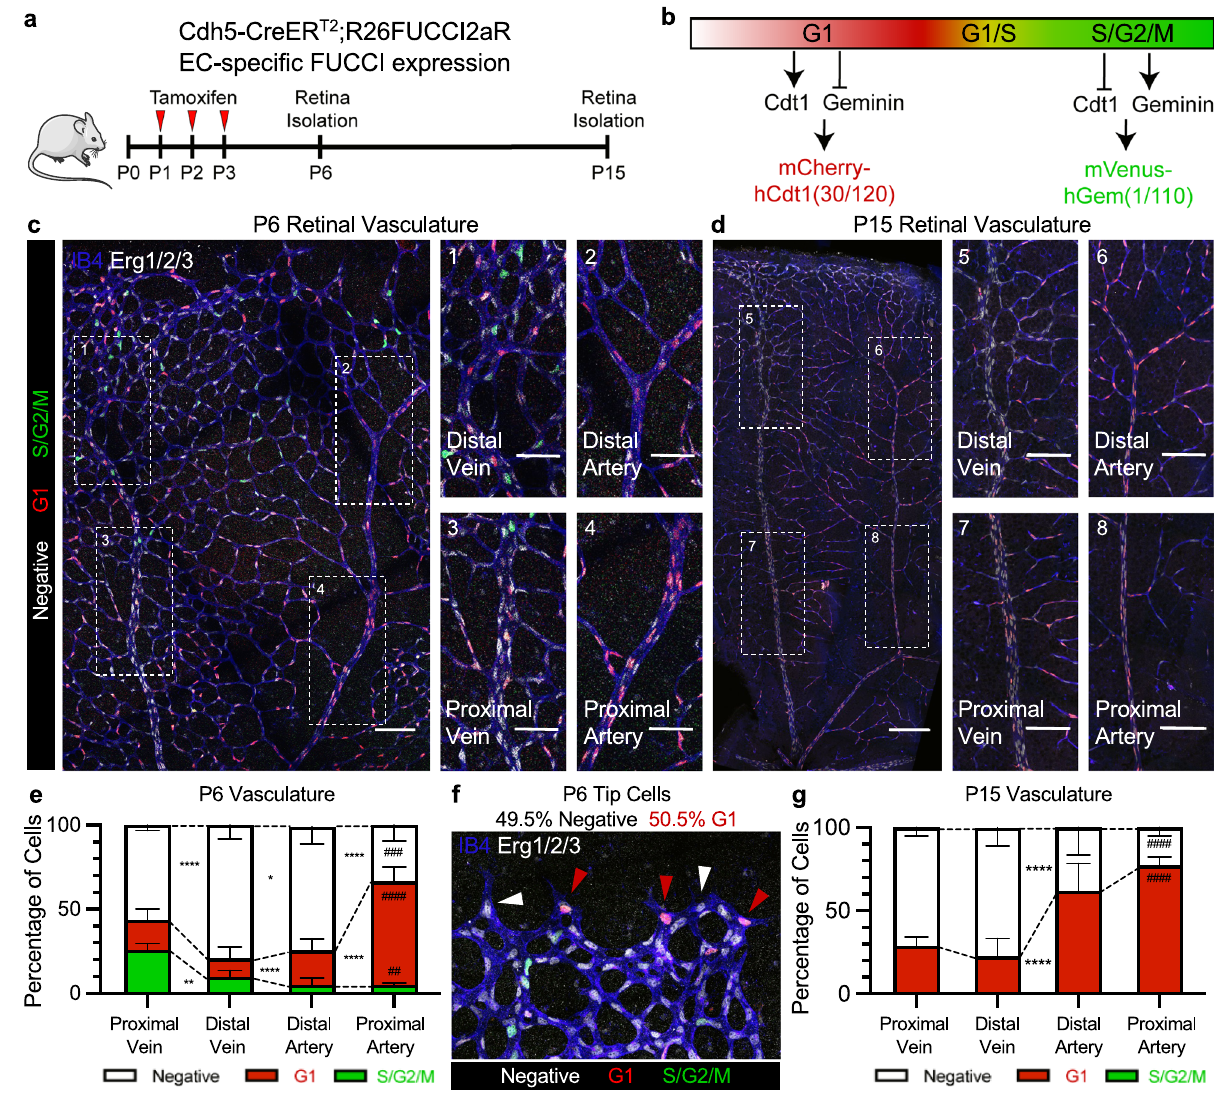
Fig. 1 | Endothelial cell cycle state during retinal vascular development. a , b Cdh5-CreER T2 ;R26FUCCI2aR transgenic mouse allows for tamoxifen-induced endothelial cell-speci fi c expression of the FUCCI reporter, which uses dynamic degradation of mVenus-hGem(1/110) and mCherry-hCdt1(30/120) in different cell cycle states to distinguish FUCCI-Negative, FUCCI-Red G1, and FUCCI-Green S/G2/M cell cycle states. c Representative confocal image of P6 retinas from Cdh5- CreER T2 ;R26FUCCI2aR mice immunostained with IB4 and anti-Erg1/2/3 (scale bar= 150 μ m), 1 – 4) magni fi ed images of vein and artery branch sections (scale bar= 50 μ m). d Representative confocal image of P15 retinas from Cdh5-Cre ER T2 ;R26- FUCCI2aR mice immunostained with IB4 and anti-Erg1/2/3 (scale bar=200 μ m), 5 – 8) magni fi ed images of vein and artery branch sections (scale bar=100 μ m).